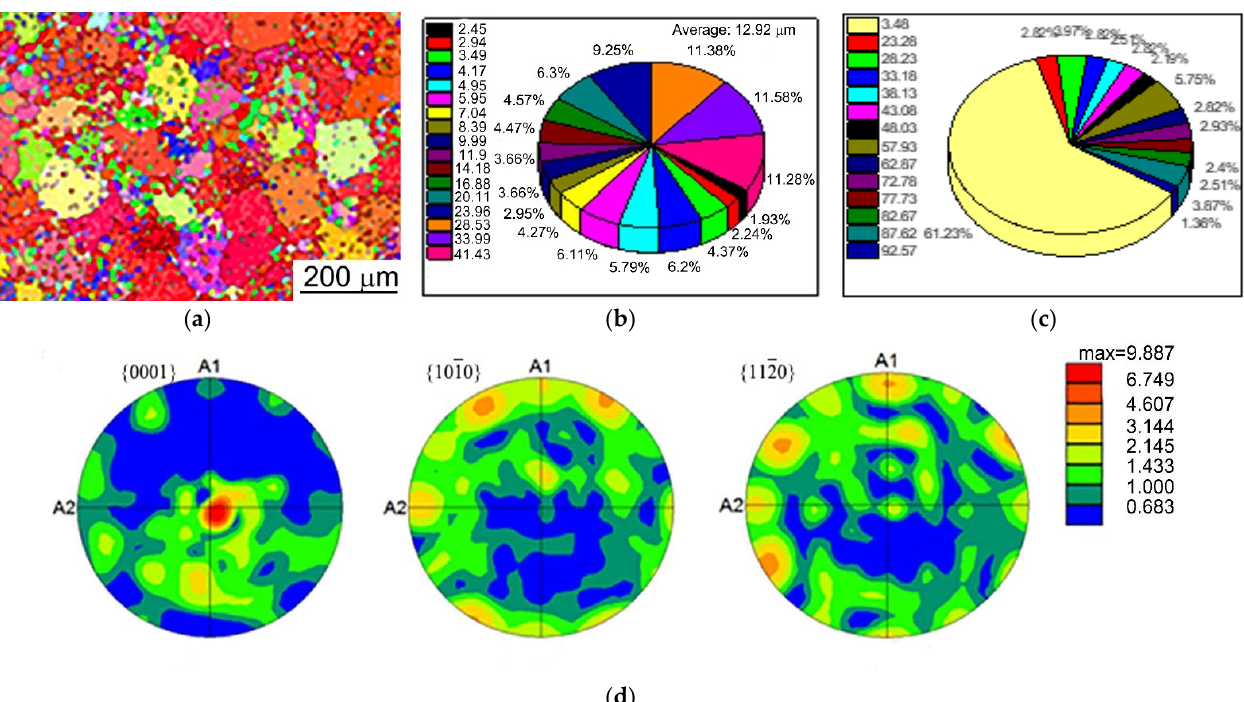
Figure 9. EBSD results of weld seam at flux coating amount of 3 mg/cm 2 . ( a ) Orientation image; ( b ) grain size; ( c ) misorientation angle; ( d ) pole figure.